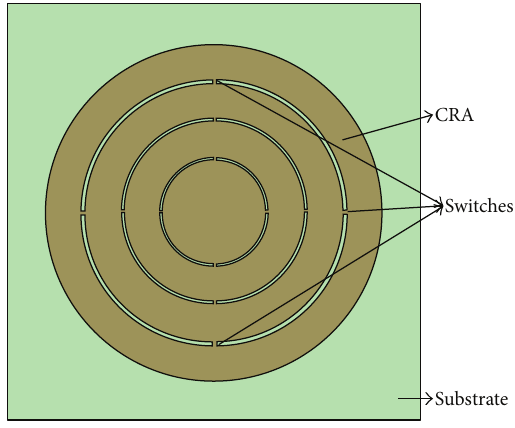
Figure 1: The Circular Reconfigurable Antenna (CRA).